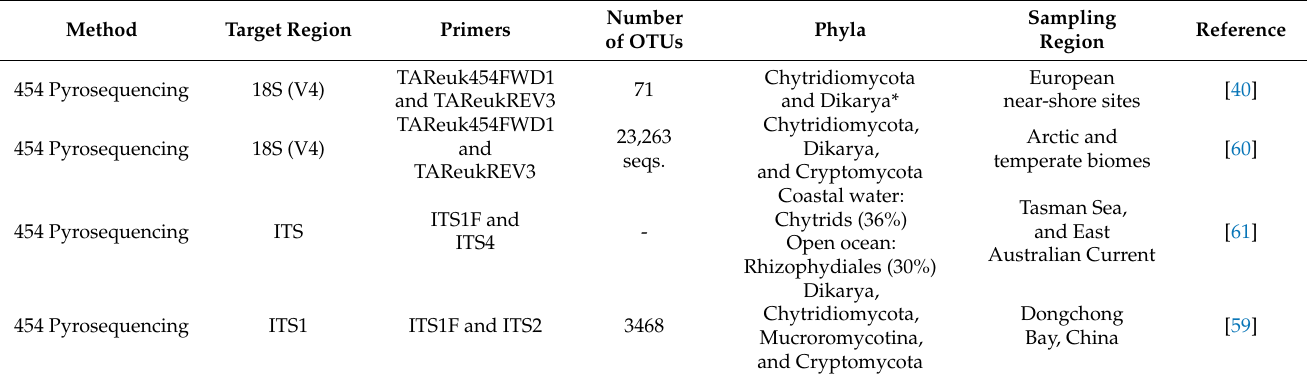
Table 2. Application of high-throughput sequencing (HTS) methods in the assessment of fungal diversity of marine water